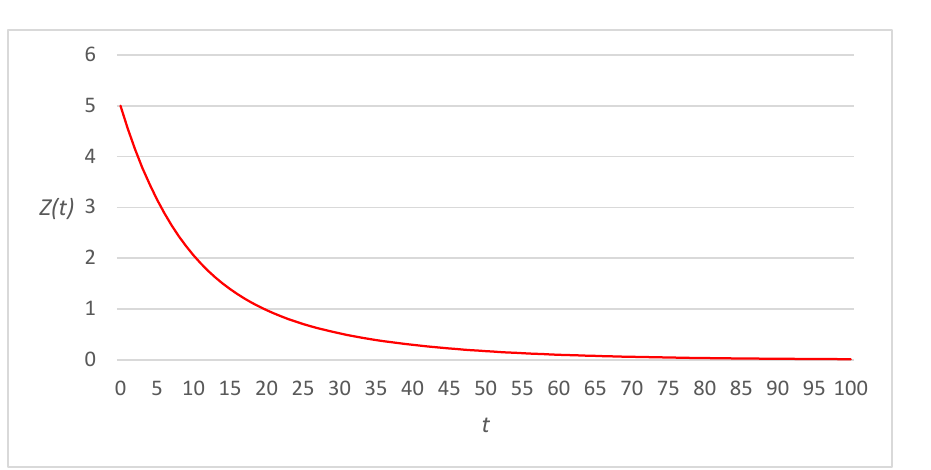
Figure 1. Time evolution of dynamical system for α = 0.1; β = 0.1; γµ = 2.5; ϕ = 0.6; Z ( 0 ) = 5 (case of linear link cost functions).